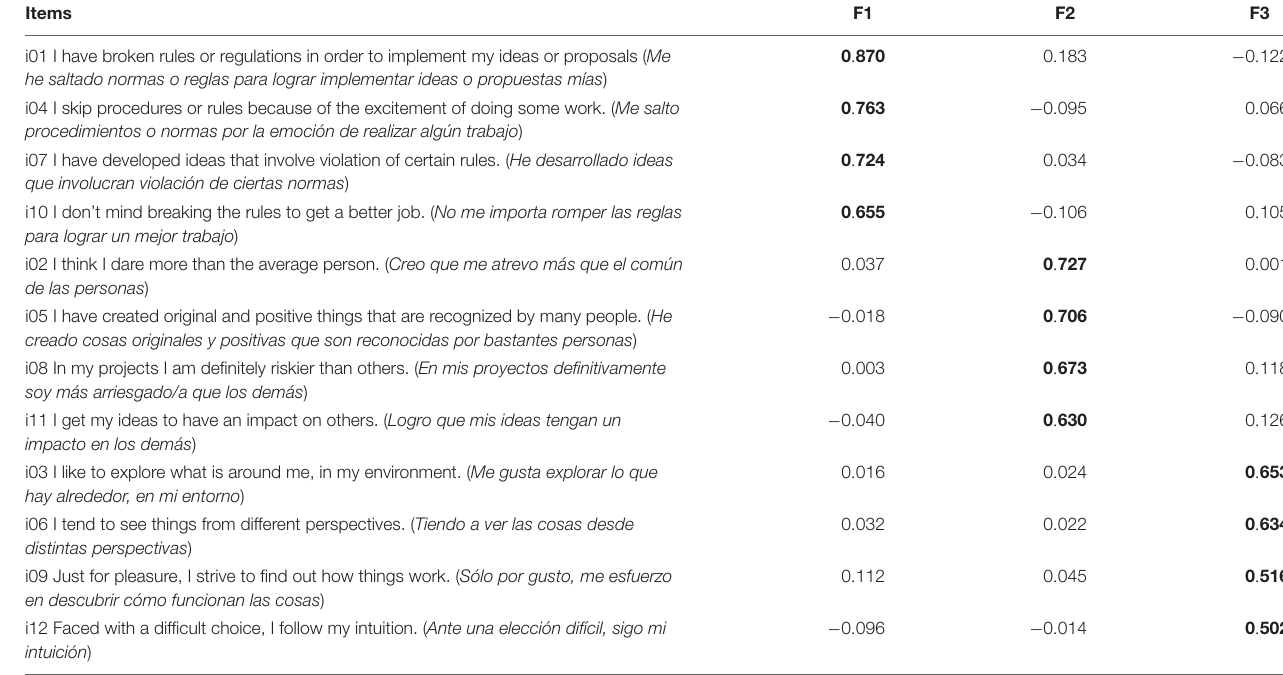
TABLE 1 | Factor loadings.